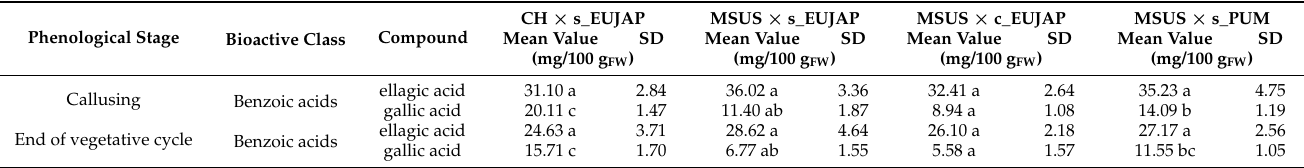
Table 2. Benzoic acid fingerprint of the tissues at the graft union. The results are reported as mg of the bioactive compound per 100 g fresh weight